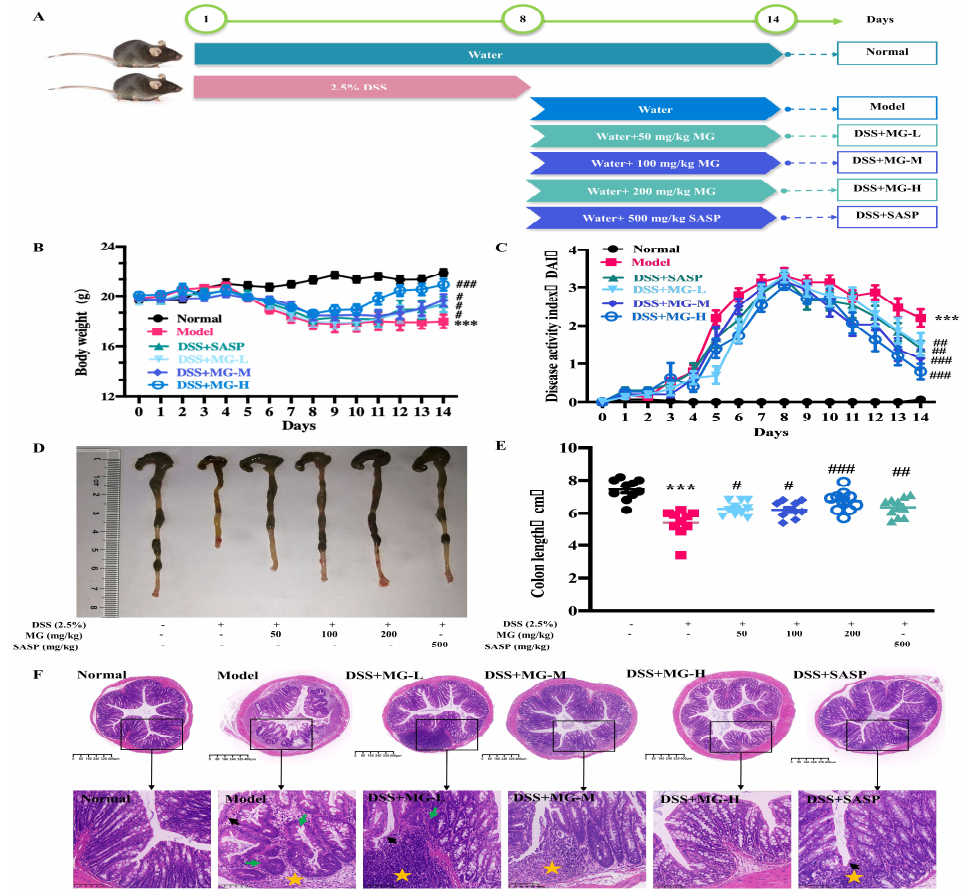
Figure 3. Effect of MG against UC caused by DSS. ( A ) Modeling and drug administration scheme of MG in DSS-induced mice. ( B ) The changes in body weight from each group of mice were measured. ( C ) Disease activity index (DAI) during the disease process. ( D , E ) Colon length of representative mice among different treatment groups. ( F ) Representative sections of hematoxylin and eosin (H&E) staining images of colon tissue (40 × , scale bar: 400 µ m) (200 × , scale bar: 100 µ m). Asterisks indicate interstitial lymphocytes infiltrated and clustered, black arrows indicate basal layer thickening and villous defects, green arrows indicate shortening, branching, and coiling of crypt structures. *** p < 0.001 vs. the normal group; # p < 0.05, ## p < 0.01, and ### p < 0.001 vs. the group treated with the DSS